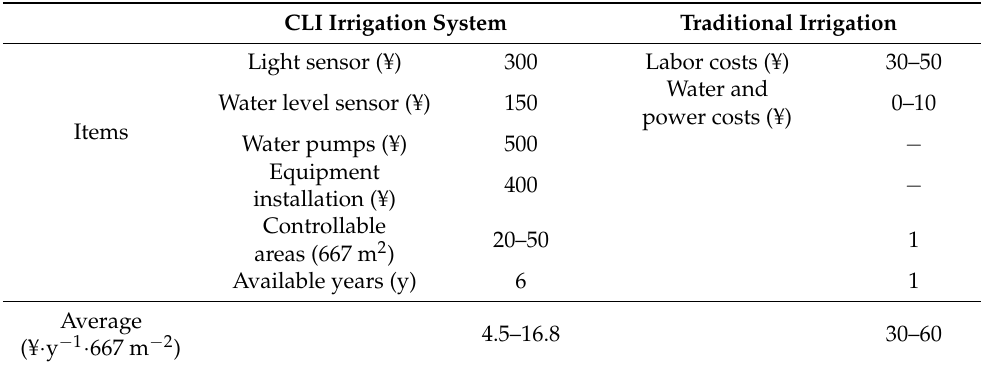
Table 4. Costs of CLI system and traditional